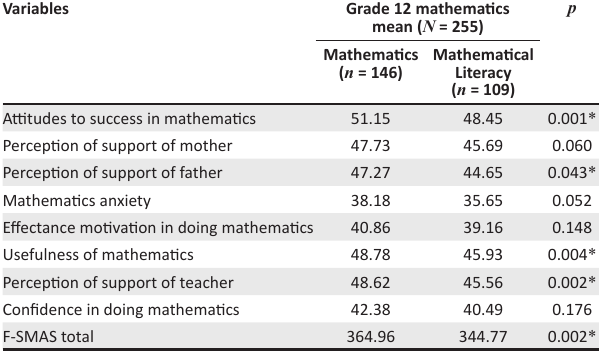
TABLE 5: Differences in student’s attitudes towards mathematics between mathematics and mathematical literacy students.